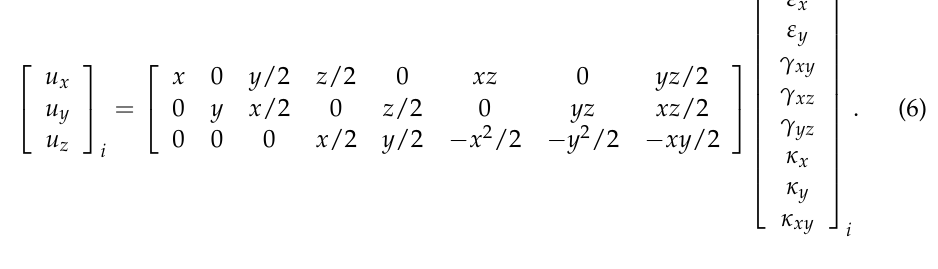
freedom in external nodes (referred to as the primary unknown or principal